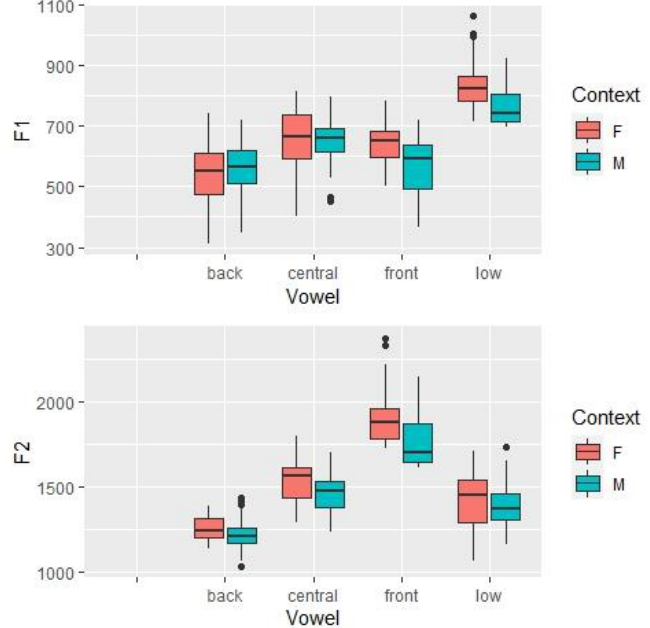
Figure 7. Average F1 and F2 of sampled vowel qualities (female = red; male = blue). Average F1 and F2 by the different vowel qualities identified can be summarized in Figure 7. There were no instances of HM vowel quality outside of the mid‑to‑low range;